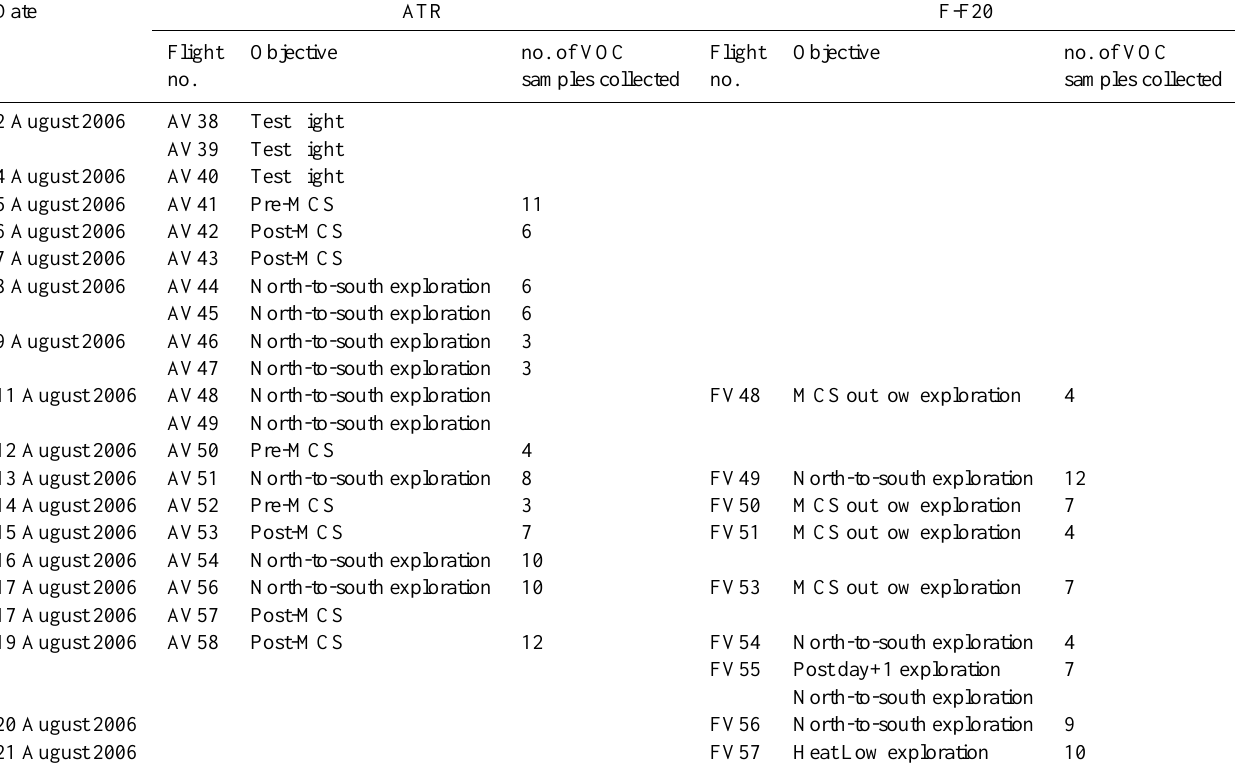
Table 2. Aircraft